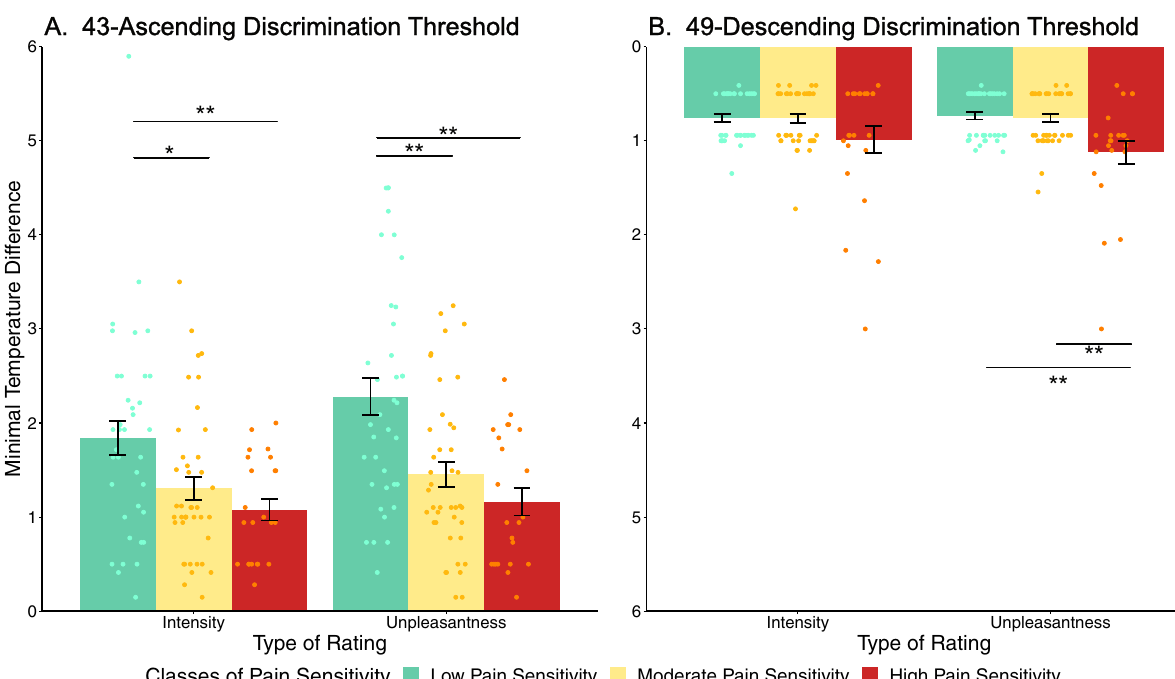
Fig. 1 Individual differences in the subjective experience of pain are further supported by differences between pain sensitivity classes in their ability to discriminate small differences in stimulus temperature via subjective reports. Compared to participants from the High (red bars) and Moderate Pain Sensitivity classes (yellow bars), participants from the Low Pain Sensitivity class (green bars) needed a signi fi cantly greater increase in temperature from 43 °C to report changes in their perceived pain intensity and unpleasantness ( p values: low – moderate: p intensity = 0.017, p unpleasantness = 0.003; low – high: p = 0.009, p = 0.0005), as shown by post-hoc two-sided Dunn ’ s tests ( A ). Conversely, the highly sensitive class required a signi fi cantly intensity unpleasantness larger decrease in temperature from 49 °C to report a change in perceived unpleasantness in relation to low or moderate sensitivity classes ( p values: low – high: p unpleasantness = 0.001; moderate – high: p unpleasantness = 0.003), as shown by post-hoc two-sided Dunn ’ s tests ( B ). The smallest temperature changes to achieve discrimination in sensation from the sensation of a reference temperature, i.e., 43-ascending discrimination thresholds and 49-descending discrimination thresholds, are represented on the y axis. Error bars represent standard error of the mean. * represents p values < 0.05; ** represents p values < 0.01. Source data are provided as an xlsx Source Data fi le. n = 101